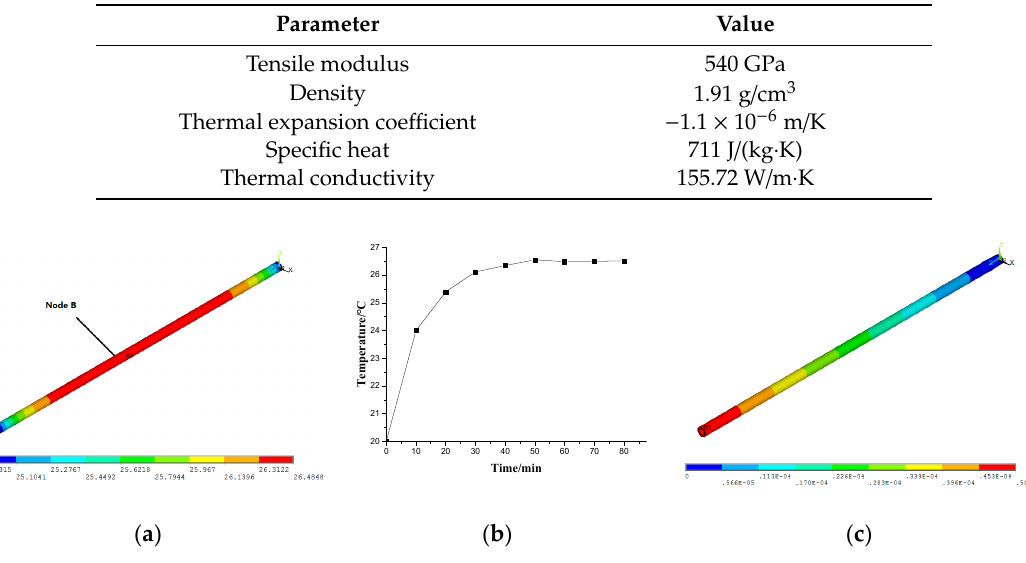
Figure 12. FE results of the improved ball screw. ( a ) Steady-state temperature field; ( b ) Temperature rise of Node B; ( c ) Displacement field.